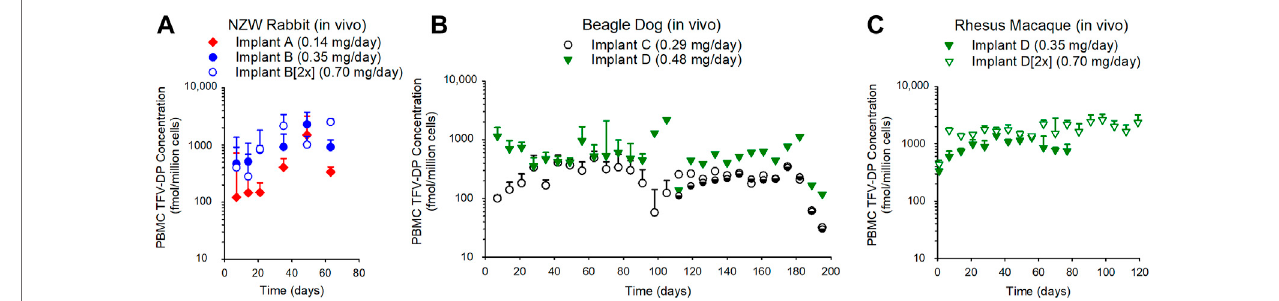
FIGURE 3 | The subcutaneous implantation of TAF implants in NZW rabbit (A) , beagle dog (B) , and rhesus macaques (C) maintained TFV-DP in PBMCs over the durationof63 – 182 days. (A) Themedian(IQR)ofPBMCTFV-DPintherabbitstudyfortheImplantA( n =5),ImplantB( n =5),andImplantB[2x]( n =5)groupswere307 (218 – 353), 944 (852 – 1050), 1129 (804 – 1841) fmol/10 6 cells, respectively. (B) The median (IQR) of PBMC TFV-DP concentrations in the dog study for Implant C ( n = 6) and Implant D ( n = 6) groups were 216 (152 – 303) and 502 (415 – 726) fmol/10 6 cells, respectively. (C) The median (IQR) of PBMC TFV-DP in the rhesus macaque study for Implant D ( n = 3), and Implant D [2x] ( n = 3) groups were 927 (877 – 948) and 1698 (1561 – 1834) fmol/10 6 cells, respectively. Each data point represents the median + standard deviations. In the dog study (B) , the remaining implants (Implant C [ n = 2 of 3 implants] and Implant D [ n = 1 of 3 implants]) were retrieved at day 182 and TFV-DP concentrations were determined during the 2-weeks washout.